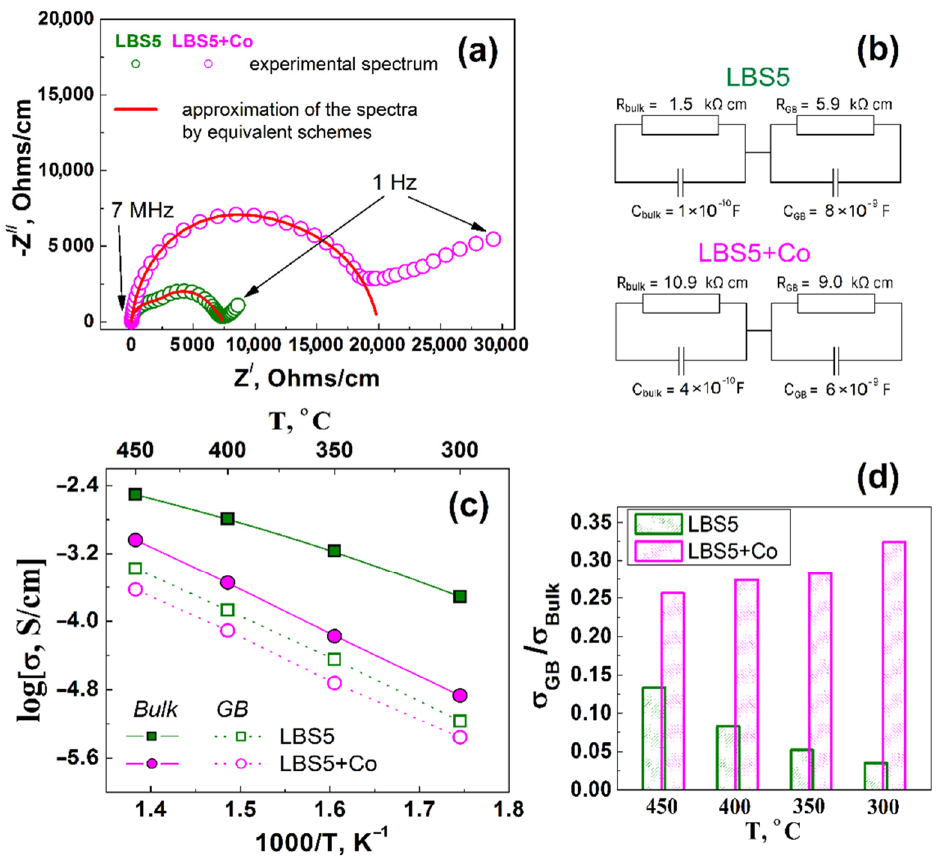
Figure 13. EIS results for La 0.95 Ba 0.05 ScO 3- δ and La 0.95 Ba 0.05 ScO 3- δ + 0.5 wt% Co 3 O 4 ceramics: ( a ) impedance spectra at 350 °C, ( b ) equivalent schemes, ( c ) temperature dependences of the bulk and GB conductivities, ( d ) σ GB / σ Bulk ratios. Table 3. Effective activation energies of the bulk and GB conductivity of La 0.95 Ba 0.05 ScO 3- δ and